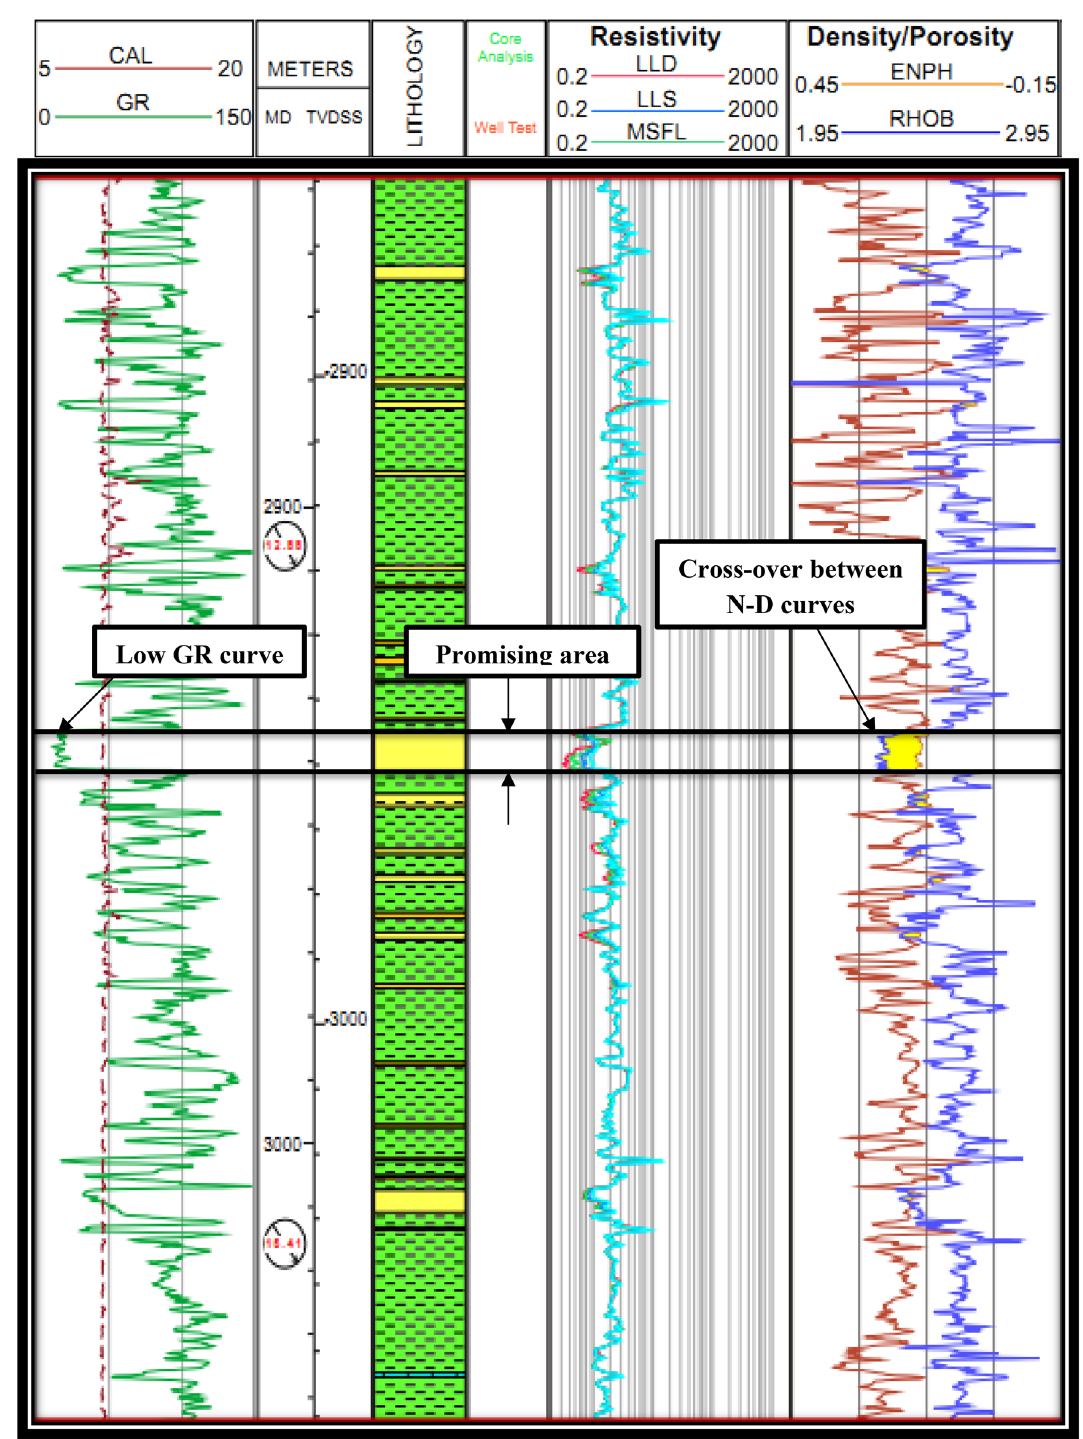
Fig. 15 Composite log at promising un-cored interval at JG-12